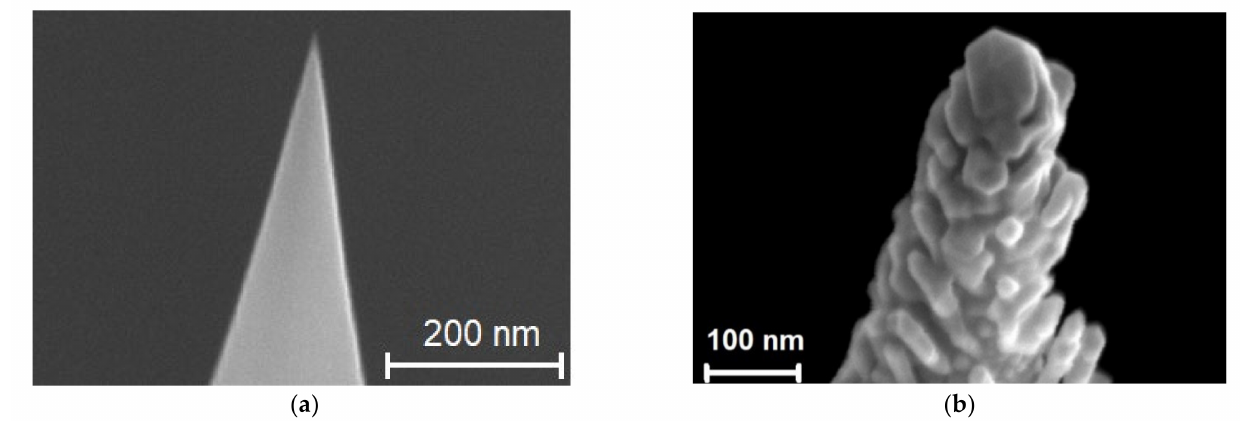
Figure 4. ( a ) SEM image of commercial Si AFM tip ( a ). ( b ) SEM image of TERS tip apex covered with Au/Ti.